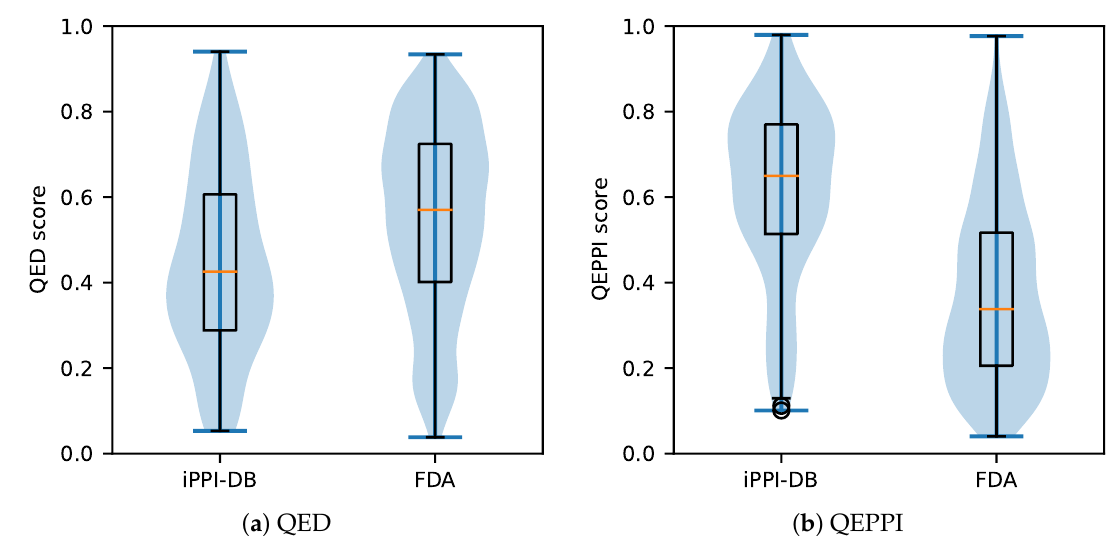
Figure 2. Distribution of QED and QEPPI in the PPI-targeting compounds dataset and FDA-approved drug dataset. Each filled area extends to represent the entire data range, with optional lines at the median. The QED score was calculated for both datasets ( a ). The QEPPI score was calculated for both datasets ( b